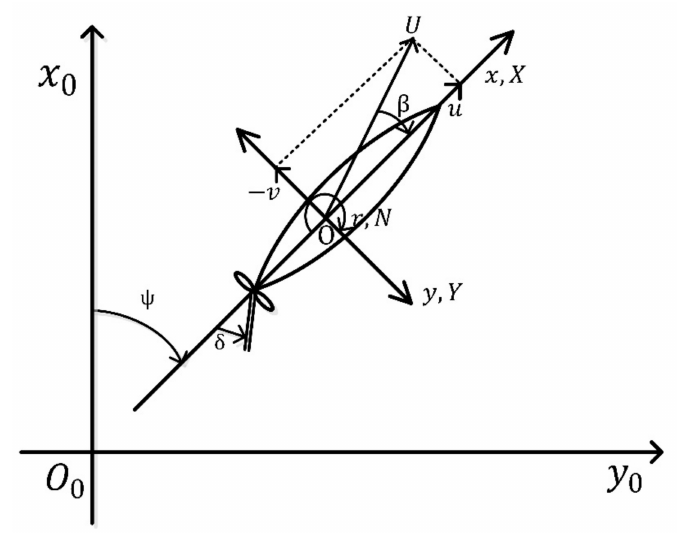
Figure 1. Coordinate